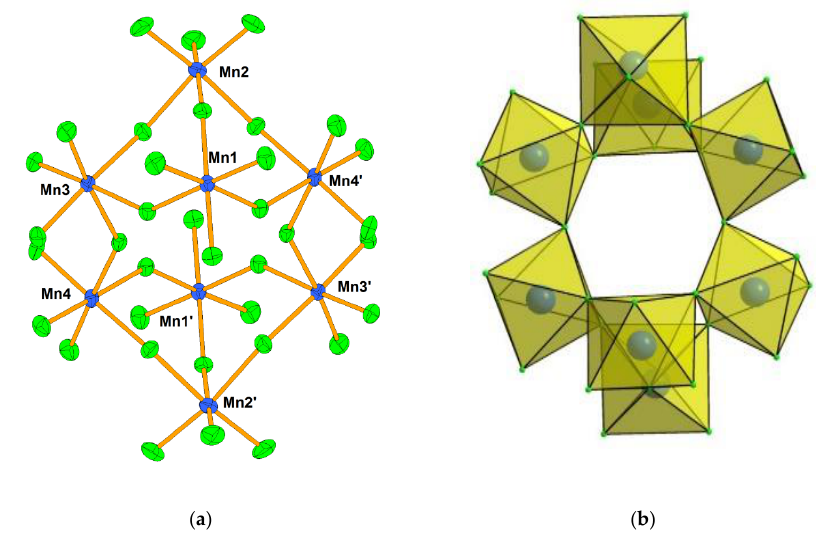
Figure 6. ( a ) The secondary contacts between the [MnF 6 ] 2– anion and [XeF 5 ] + cations in the crystal